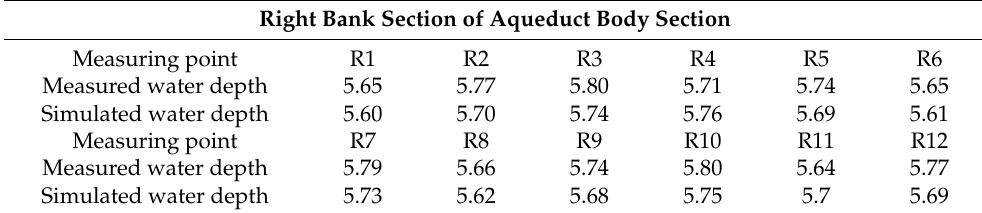
Table 3. Comparison between measured water depth and simulated water depth on the right bank of the aqueduct. Right Bank Section of Aqueduct Body